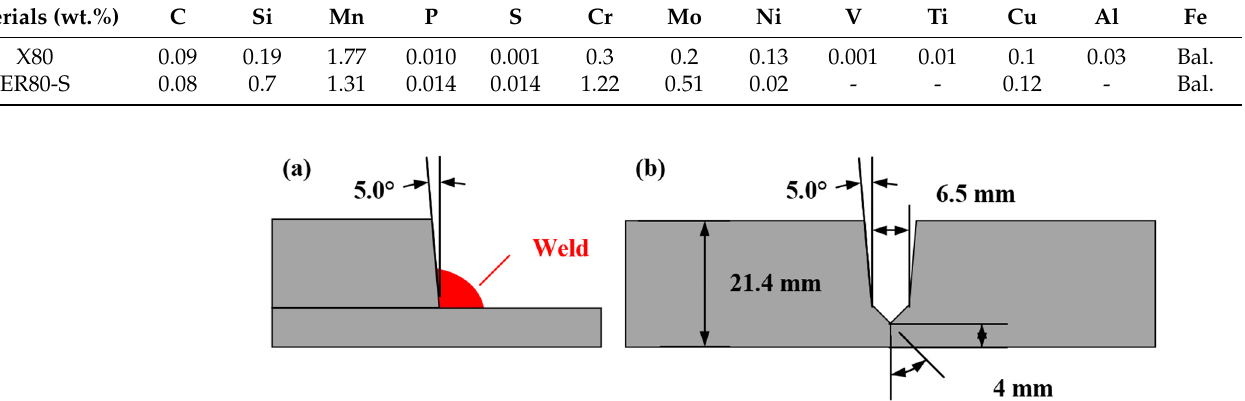
Table 1. The chemical composition of X80 steel and ER80-S welding wire (wt.%). Materials (wt.%)